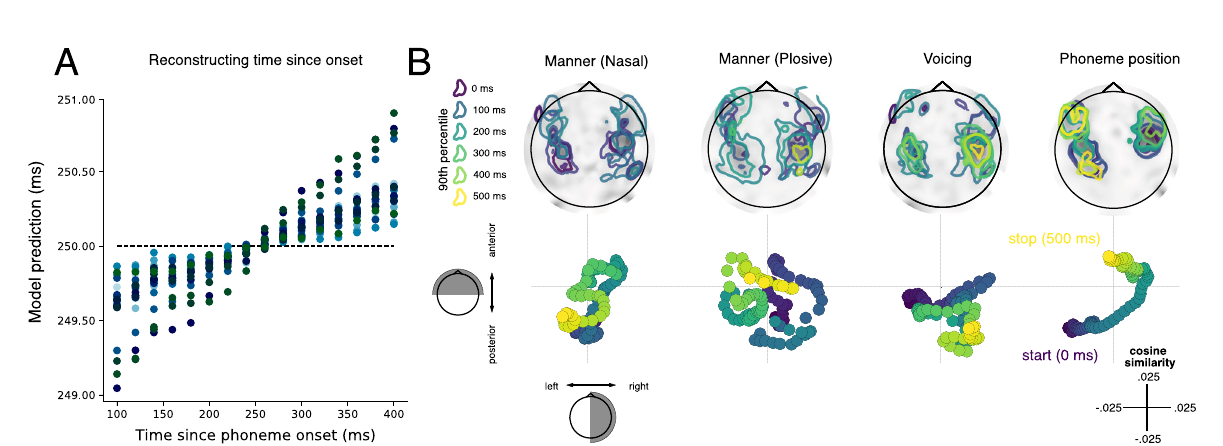
Fig. 4 | Spatial evolution of processing trajectory. A Reconstructing time since phoneme onset from 15 equally spaced samples from 100 to 400ms. The hor- izontal dashed line indicates mean of time latency (i.e. what would be recon- structed in absence of evidence to the contrary). The coloured dots represent the 21 participants at a given time sample. B Decoding model coef fi cients plotted as topographies(above)andtrajectories(below)overtime.Coef fi cientsareshownfor the decoding of three phonetic features and phoneme position. Phoneme onset is showninthedarkestpurple(0ms)andcoloursshifttowardsyellowasafunctionof